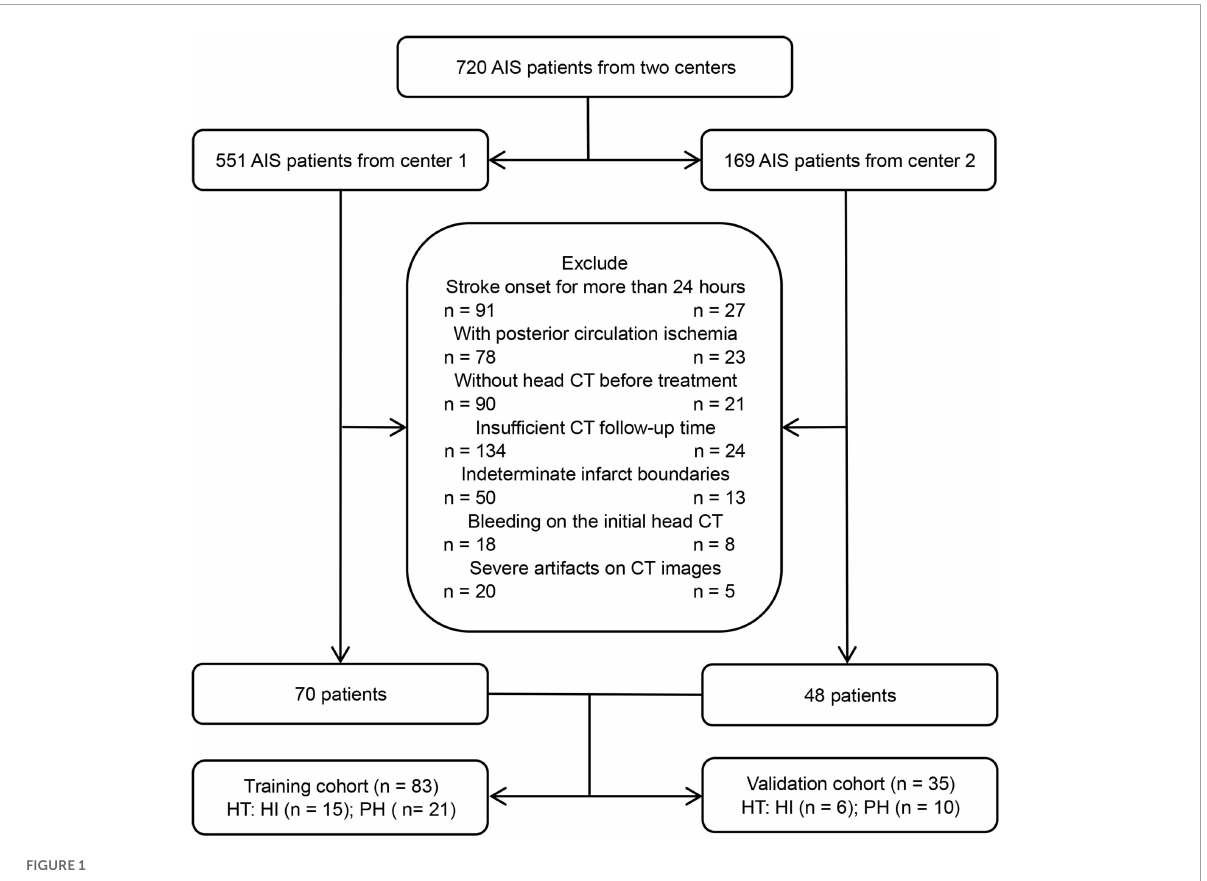
FIGURE1 The flow chart of patient inclusion and exclusion criteria.